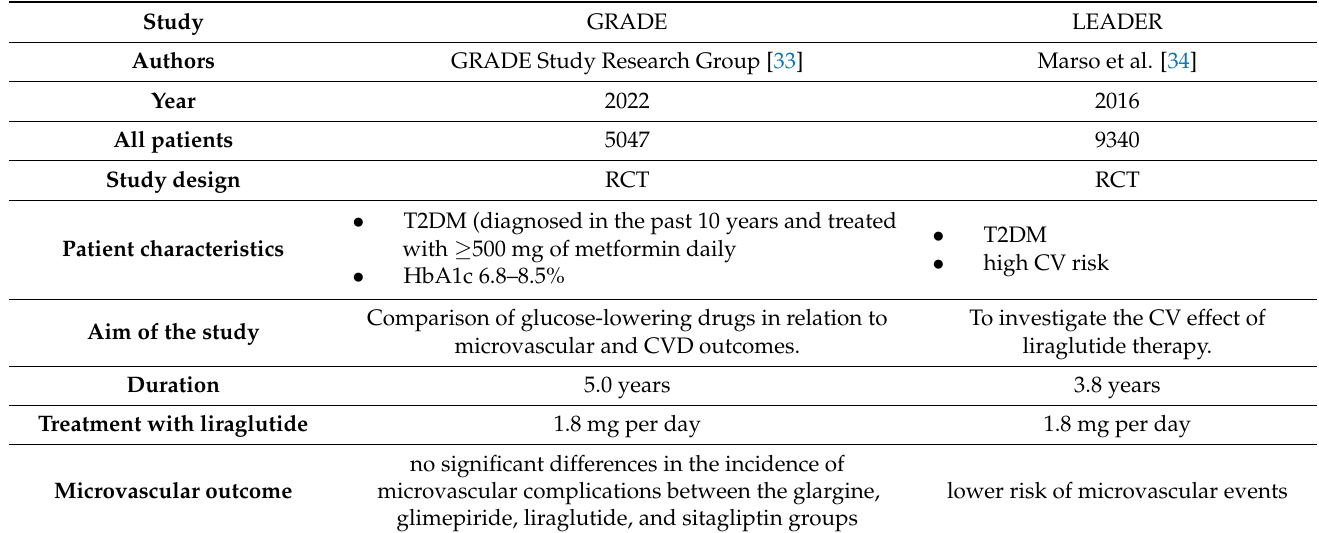
Table 4. Comparison of studies on the effect of liraglutide treatment on microvascular complica- tions